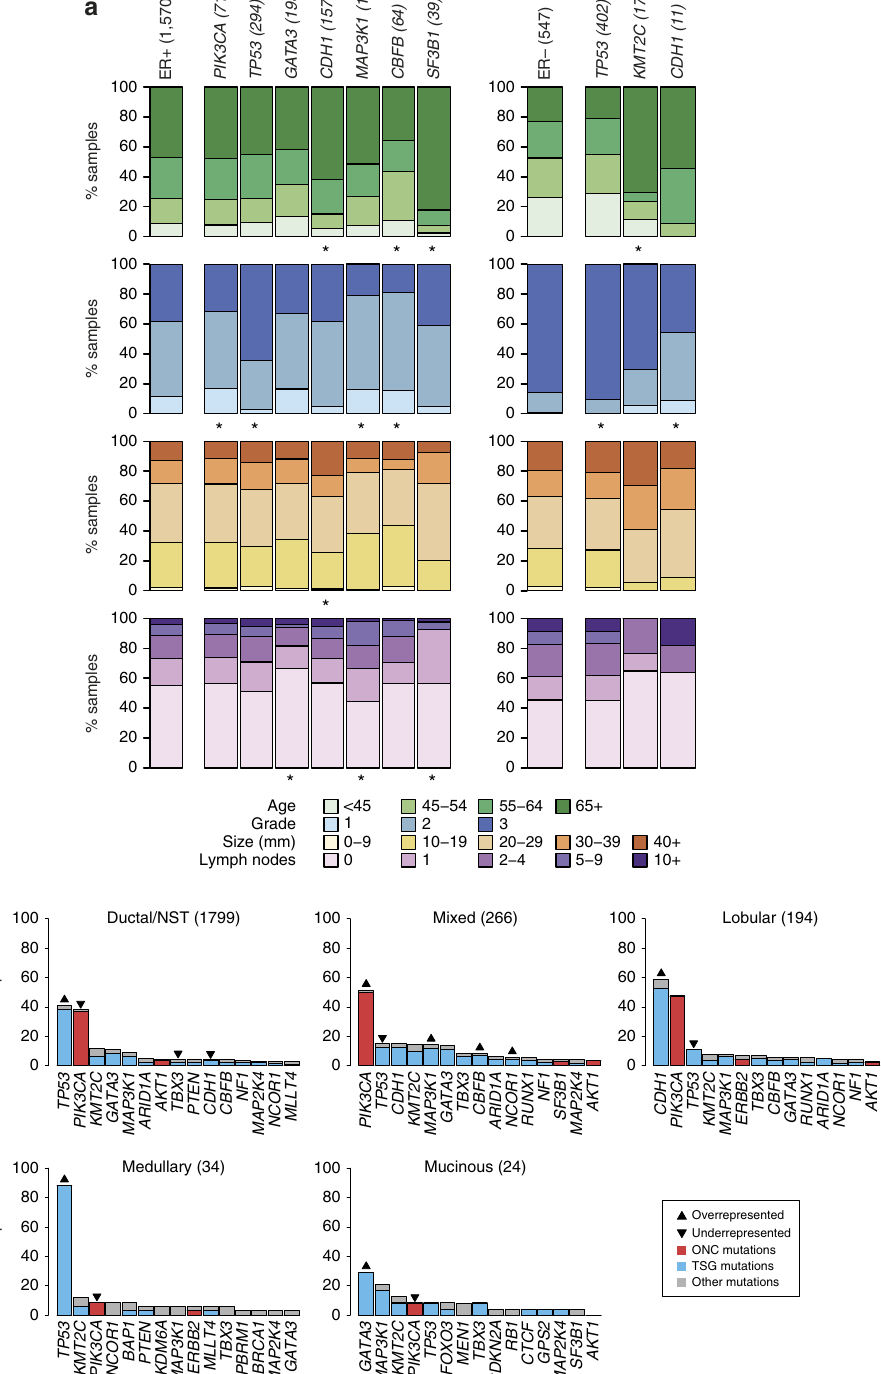
Figure 2 | Associations between mutations and clinical-pathological variables. ( a ) The associations between functional mutations in Mut-driver genes and patient age, tumour grade, size and number of lymph nodes involved are depicted for ER þ (left) and ER (cid:3) (right) samples. Bars depict the categorical distributions of each variable in samples harbouring a functional mutation in the specified gene. The single bars on the left of each panel show the distributions of the variables for either all ER þ or ER (cid:3) samples. The numbers of samples with mutations in the genes are shown in brackets. For each gene, we looked for a difference in the distributions of a variable between wild-type and mutant samples. All genes for which at least one association was found ( w 2 -test; FDR ¼ 0.05) are shown, and ‘ (cid:4) ’ indicates the significant associations. The analysis was performed for genes mutated in at least 1% of ER þ or ER (cid:3) samples. ( b ) Bars depict prevalence of mutations in Mut-driver genes across histological subtypes. The 15 most frequently mutated genes in each subtype are shown. The coloured part of each bar indicates functional mutations, which were defined as recurrent mutations that contribute to an oncogene’s ONC score (red), or inactivating mutations that contribute to a tumour suppressor gene’s TSG score (see main text). Both recurrent and inactivating mutations were considered for TP53 . Up arrows and down arrows indicate over/under-representation of mutations, respectively, in the specified gene relative to all other samples (Fisher’s exact test; FDR ¼ 0.05). NST, no special type. NATURE COMMUNICATIONS|7:11479|DOI: